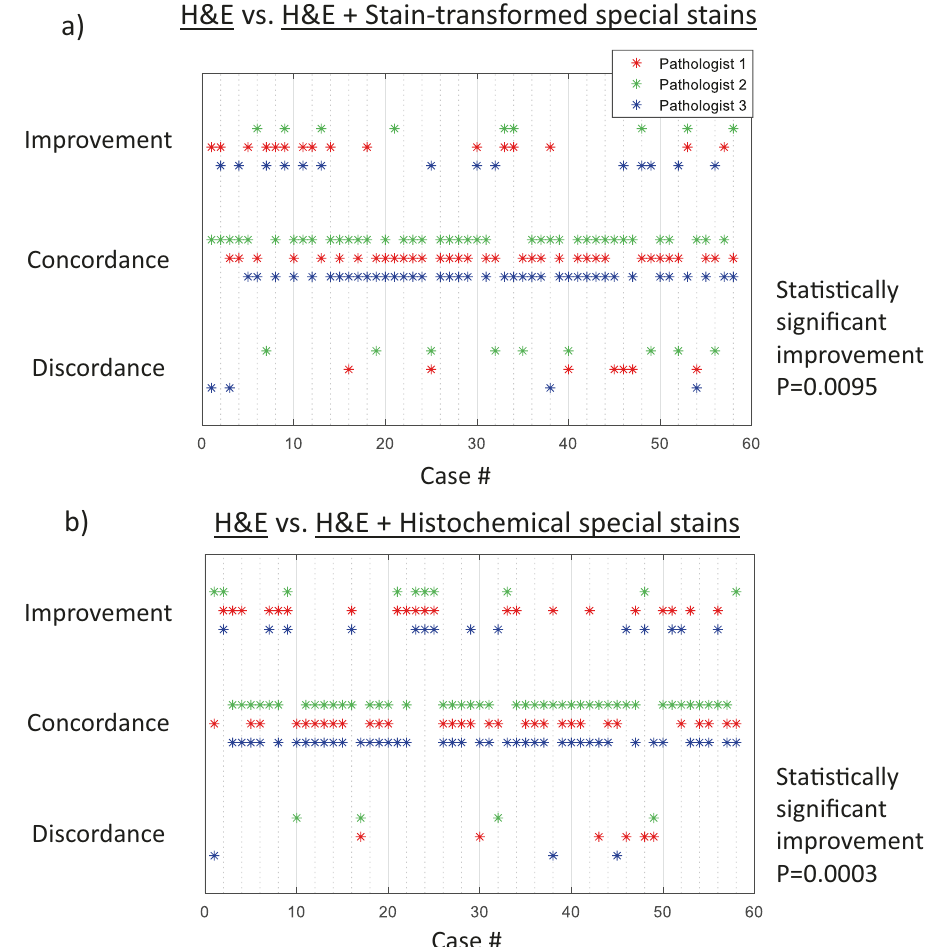
Fig. 4 Visualization of the improvements, concordances, and discordances by case number for the two comparisons. a Comparison of H&E only vs. H&E and the three stain-transformed special stains coming from the same tissue section. The use of the three stain-transformed special stains results in a statistically signi fi cant improvement over H&E only ( P = 0.0095). b Comparison of H&E only vs. H&E and the three special stains (all histochemically stained) coming from serial tissue sections. The use of the three histochemically stained special stains results in a statistically signi fi cant improvement over H&E only ( P = 0.0003). P values were calculated using a one-sided t -test. No adjustments for multiple comparisons were